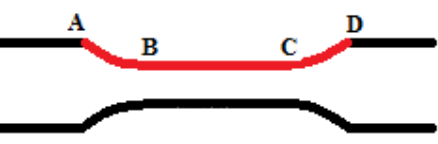
Table 4. Interaction time and fatigue test results. NT refers to the untreated sample.